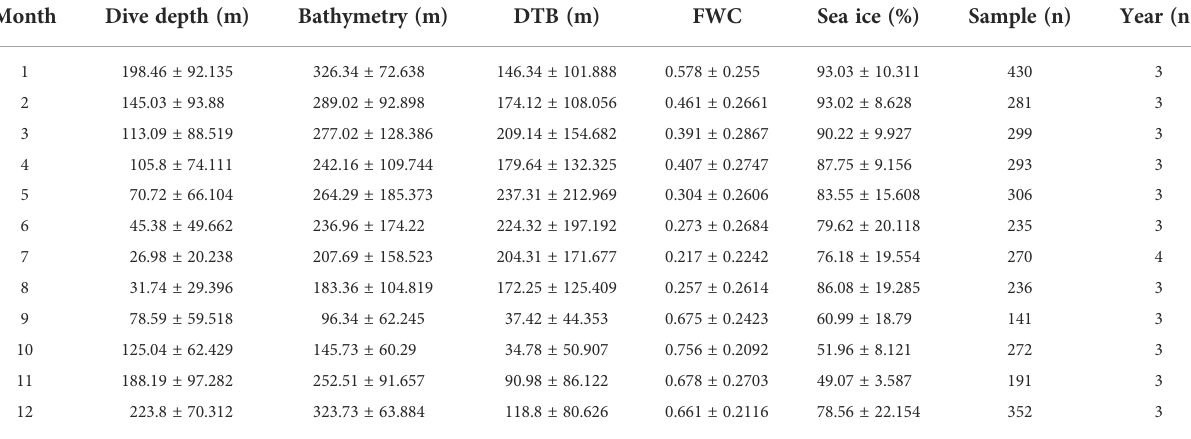
TABLE 4 Summary information on bowhead whale putative foraging behaviour with georeferenced environmental covariates.